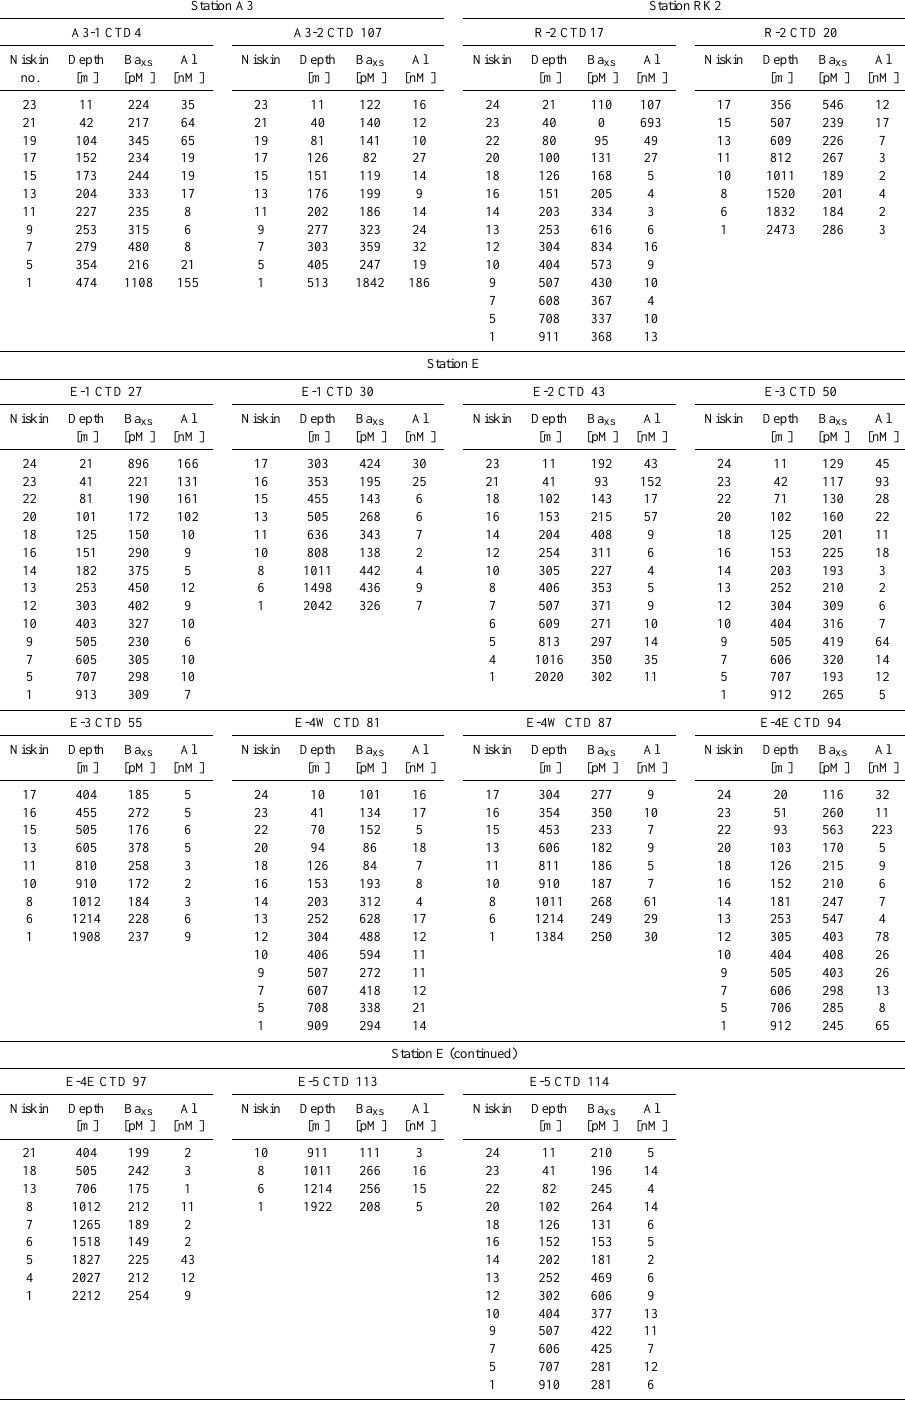
Table A1. Excess particulate biogenic Ba (Ba xs ; pM) and particu- late Al (nM) during KEOPS